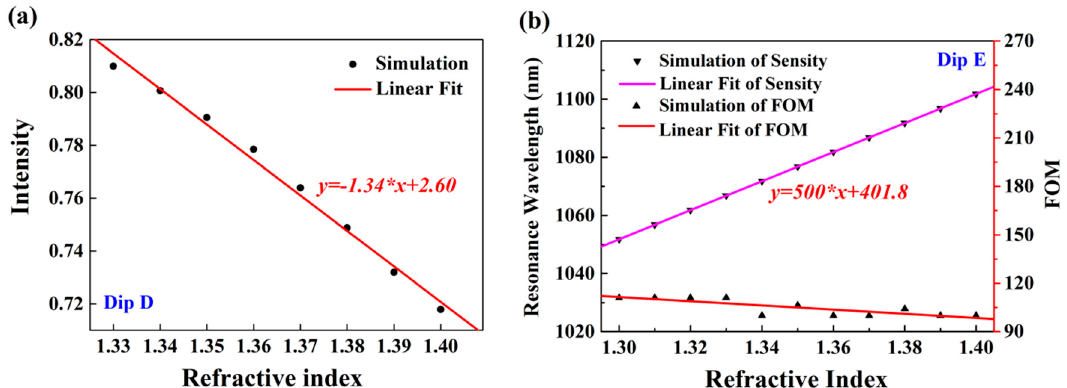
Figure 9. Sensing performances of proposed double-layer plasmonic grooves at incident angle 30°. ( a ) The relationship of the intensity of dip D and sample RIs. ( b ) The relationship of wavelength positions of dip E and sample RIs, and corresponding FOM.